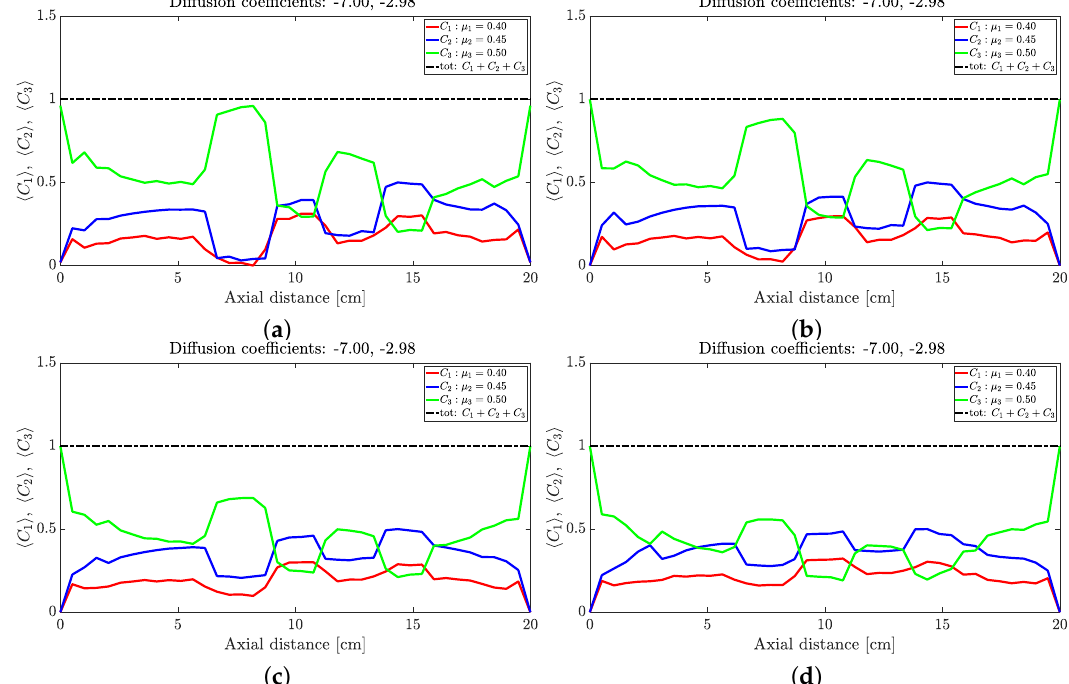
Figure 4. Snapshots of ternary mixture at: ( a ) 45 s, ( b ) 50 s, ( c ) 70 s, ( d ) 100 s. The corresponding diffusion coefficients are − 7 and −